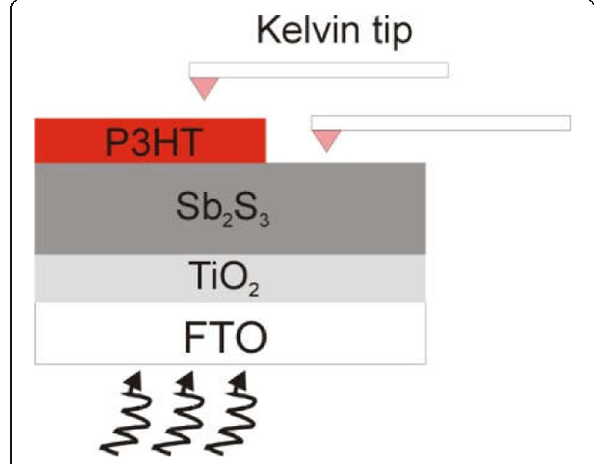
Fig. 8 Illustration of SP measurement of Sb 2 S 3 /P3HT interface by